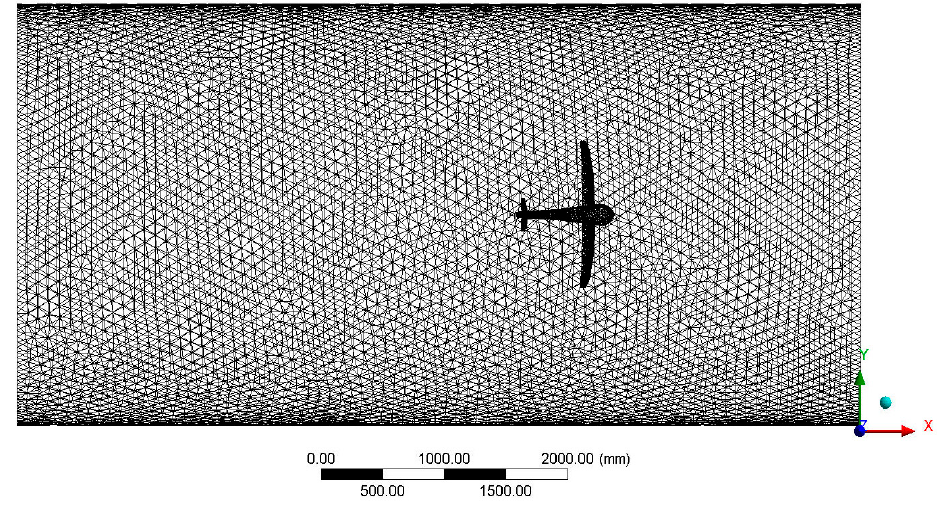
Figure 8. Discretization of computational model.